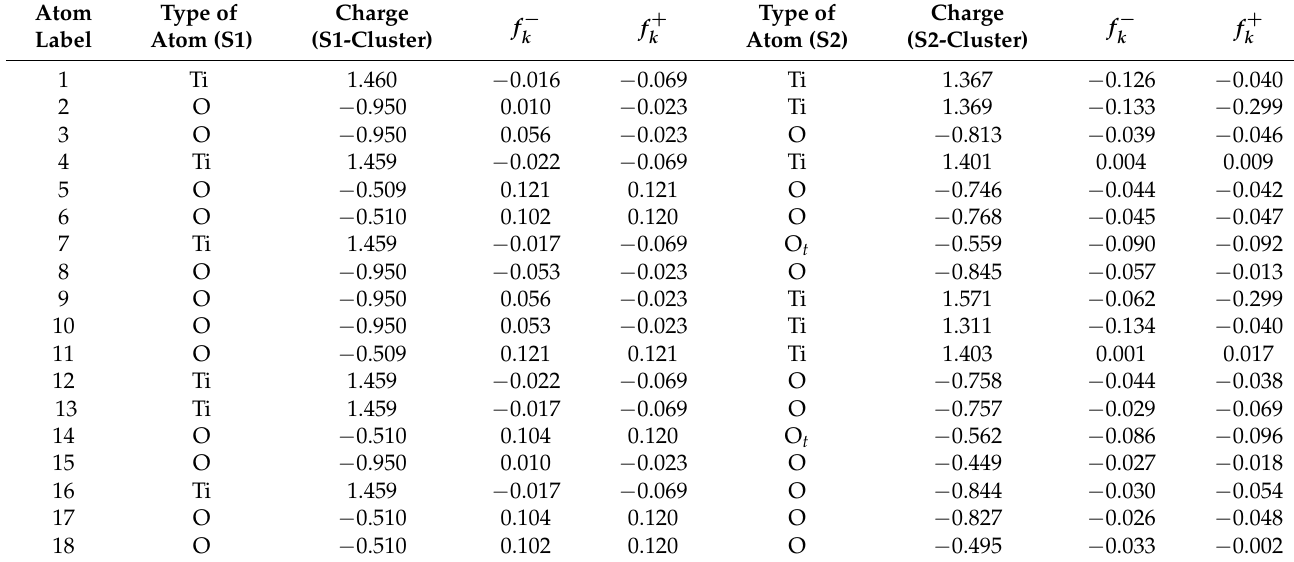
Table 2. The condensed Fukui functions ( f + Figure 1) in gas